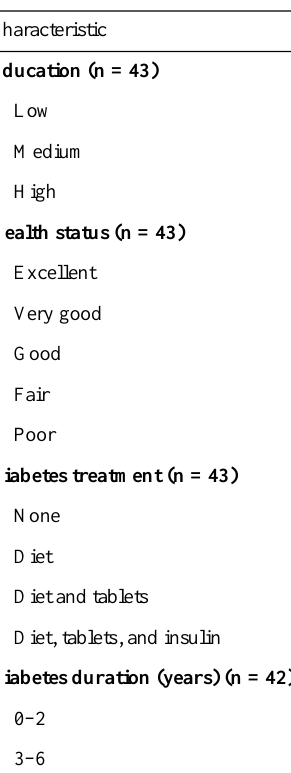
Table 2. Enrollee